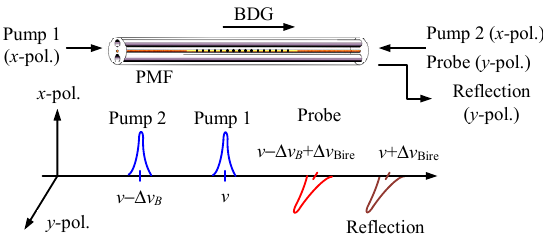
Fig. 13 Schematic diagram of generation and detection of the BDG in a